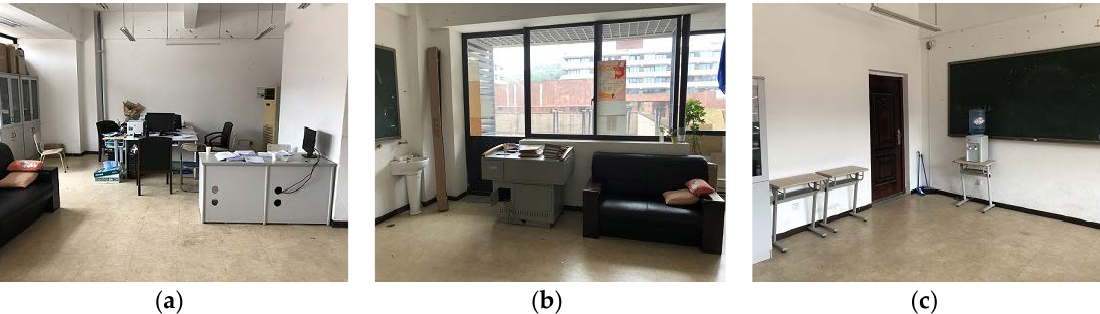
Figure 5. Part of the scene in the actual test environment. ( a ) An office area with tables, chairs, computers, and bookcases; ( b ) the wall with large transparent glass windows; ( c ) the door of the office, which is the starting point and end point of the robot's trajectory.